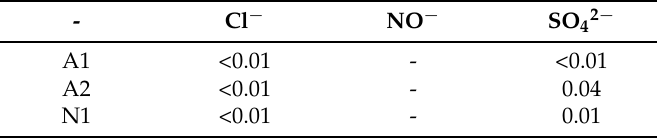
Table 2. Soluble salt content of sands (% by weight).